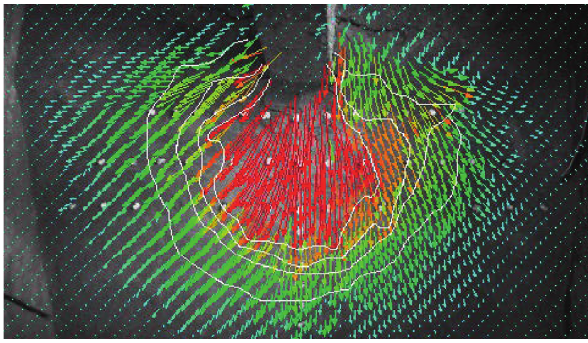
Figure 12: Displacement attenuation of soil around pile. Table 3: The calculative width adopted in civil